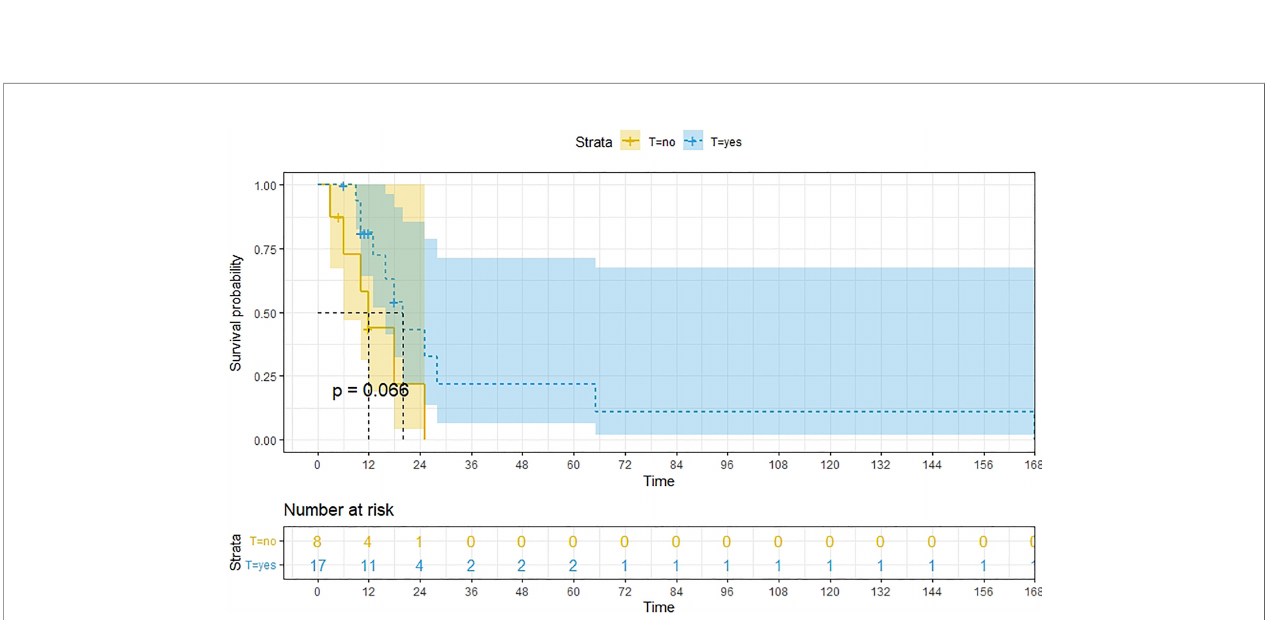
FIGURE 11 | Kaplan-Meier survival curves for OS in patients of TAH-based surgery with and without other treatments. The median OS for them are 20m,12m respectively.